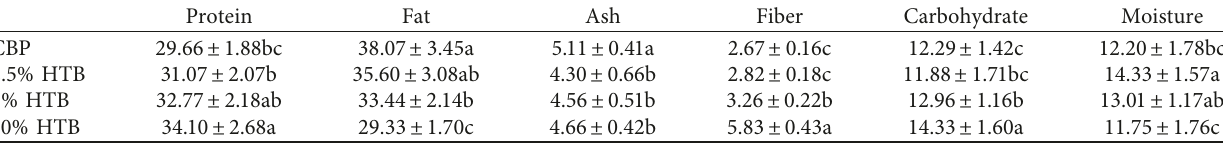
Table 3: Nutritional value of beef patties prepared with different concentrations of husk tomatoes (mean values ± SD). Protein Fat Ash Fiber Carbohydrate